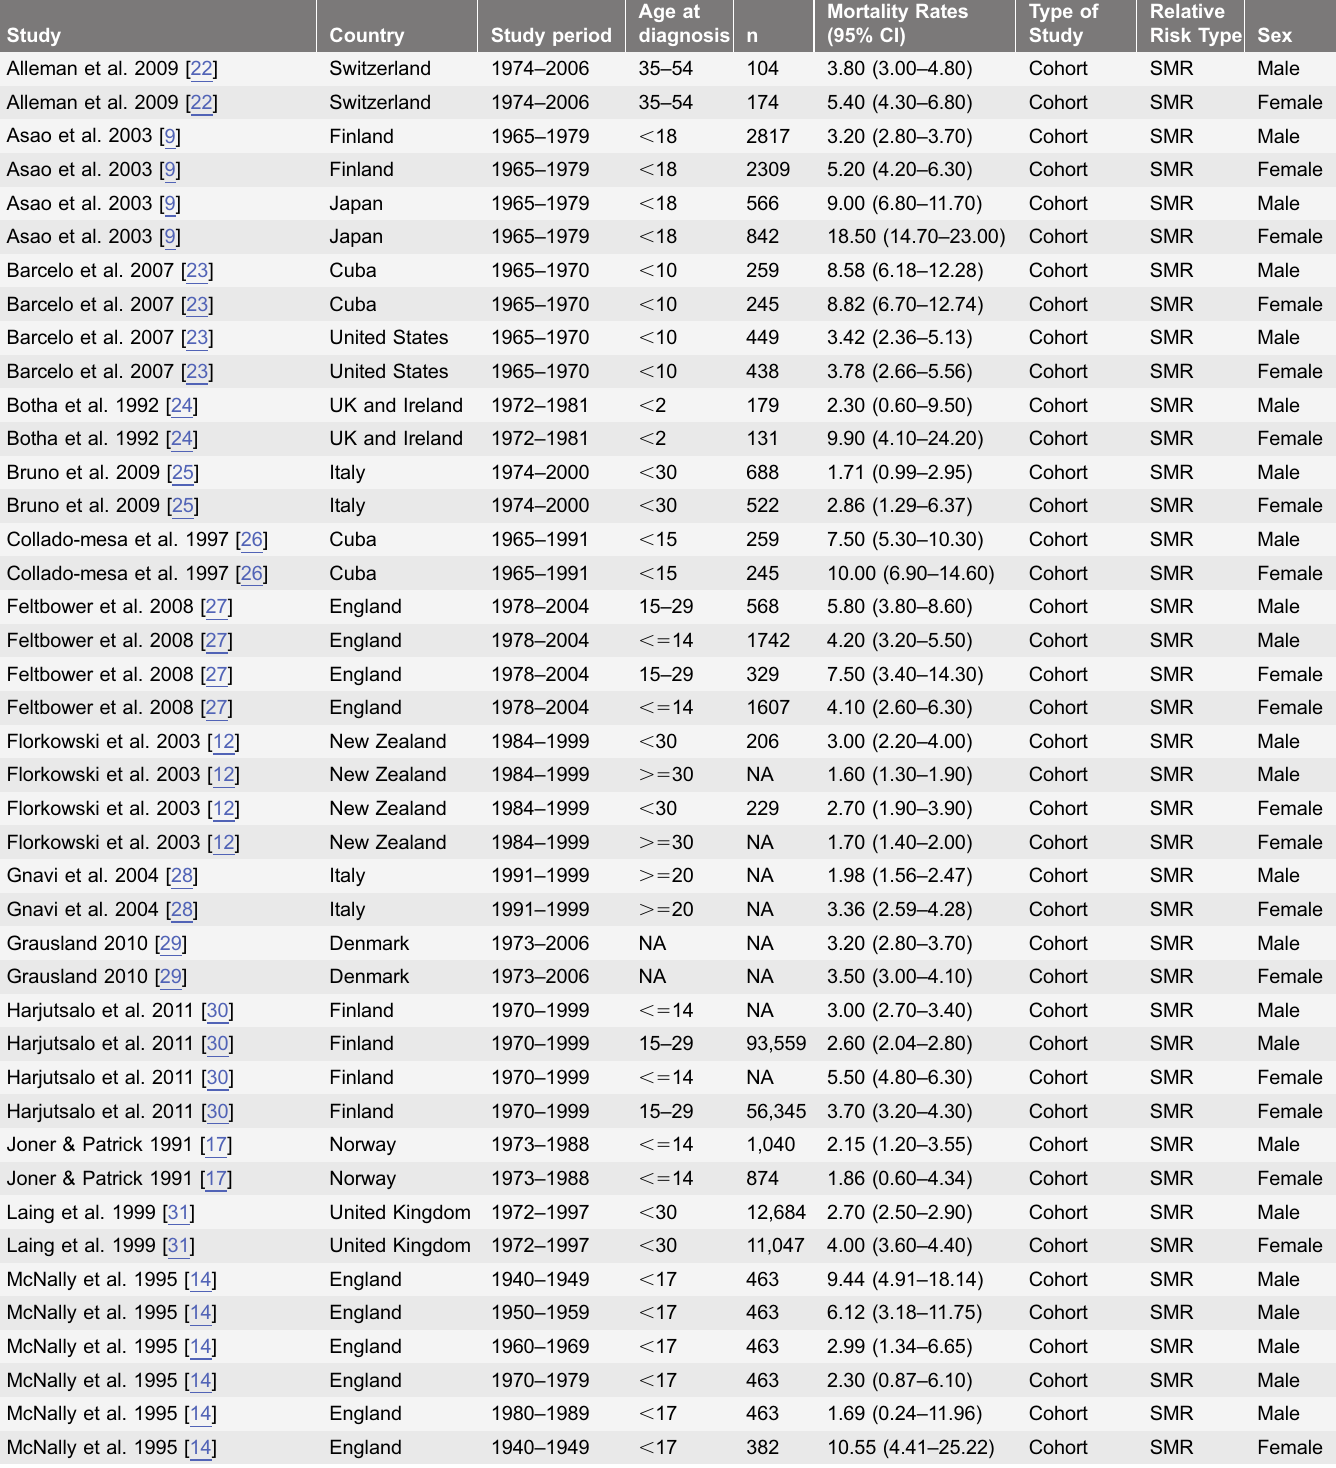
Table 1. List of studies used in meta-analysis, country of analysis, date of conducted studies, age at diagnosis, mean age patients, number of patients in the study, percentage of males in study, years of follow-up, mortality rates and measurement of risk of